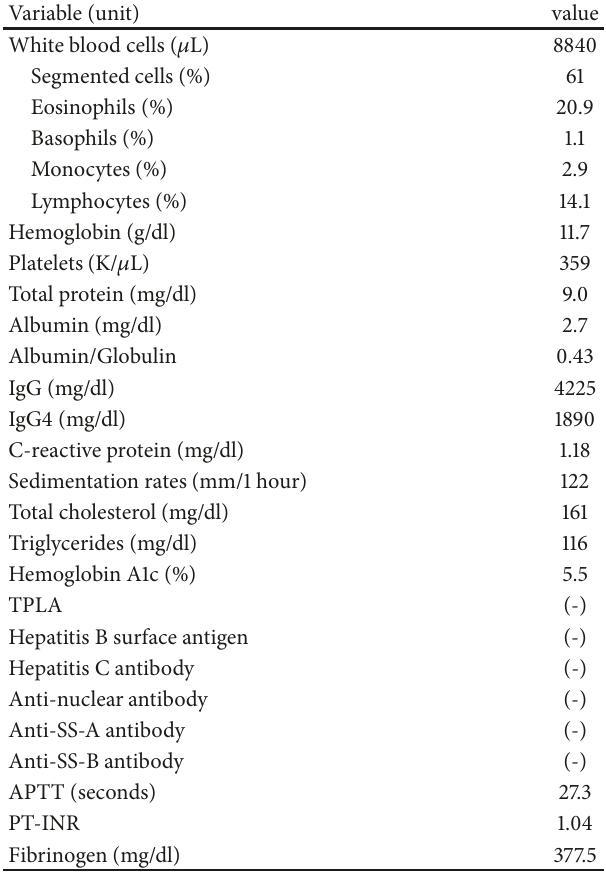
Table 1: Laboratory test results on